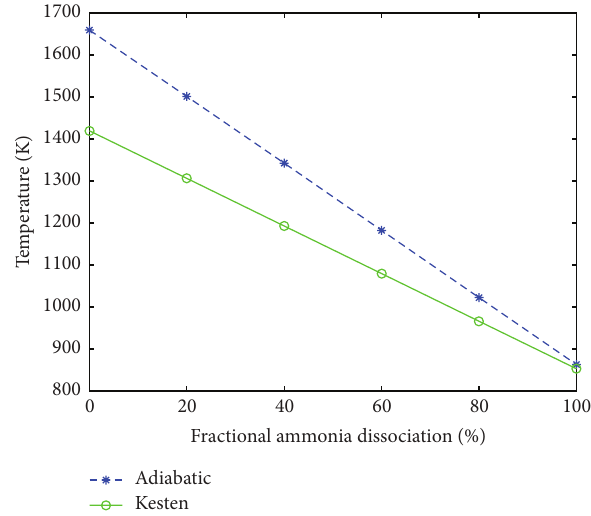
Figure 1: Variation of total temperature with NH 3 decomposition